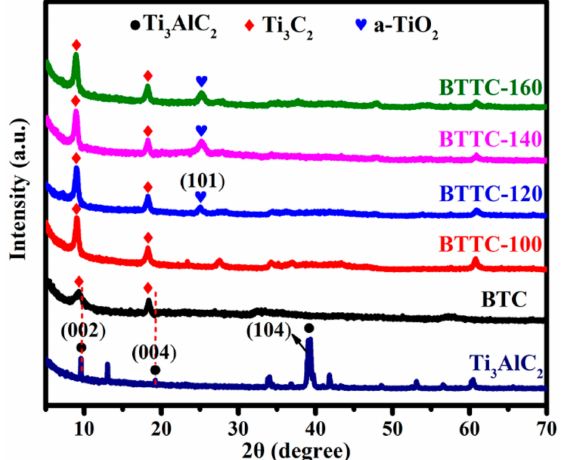
Figure 2. XRD patterns of raw Ti 3 AlC 2 , BTC, and BTTC-x (x = 100, 120, 140, and 160 ◦ C,